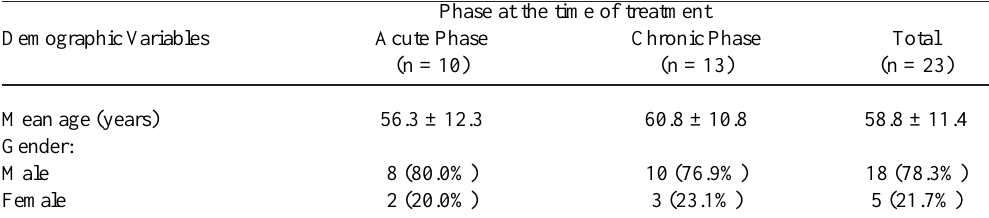
Table 2. Demographic and clinical data of the 23 patients submitted to endovascular treatment of complicated